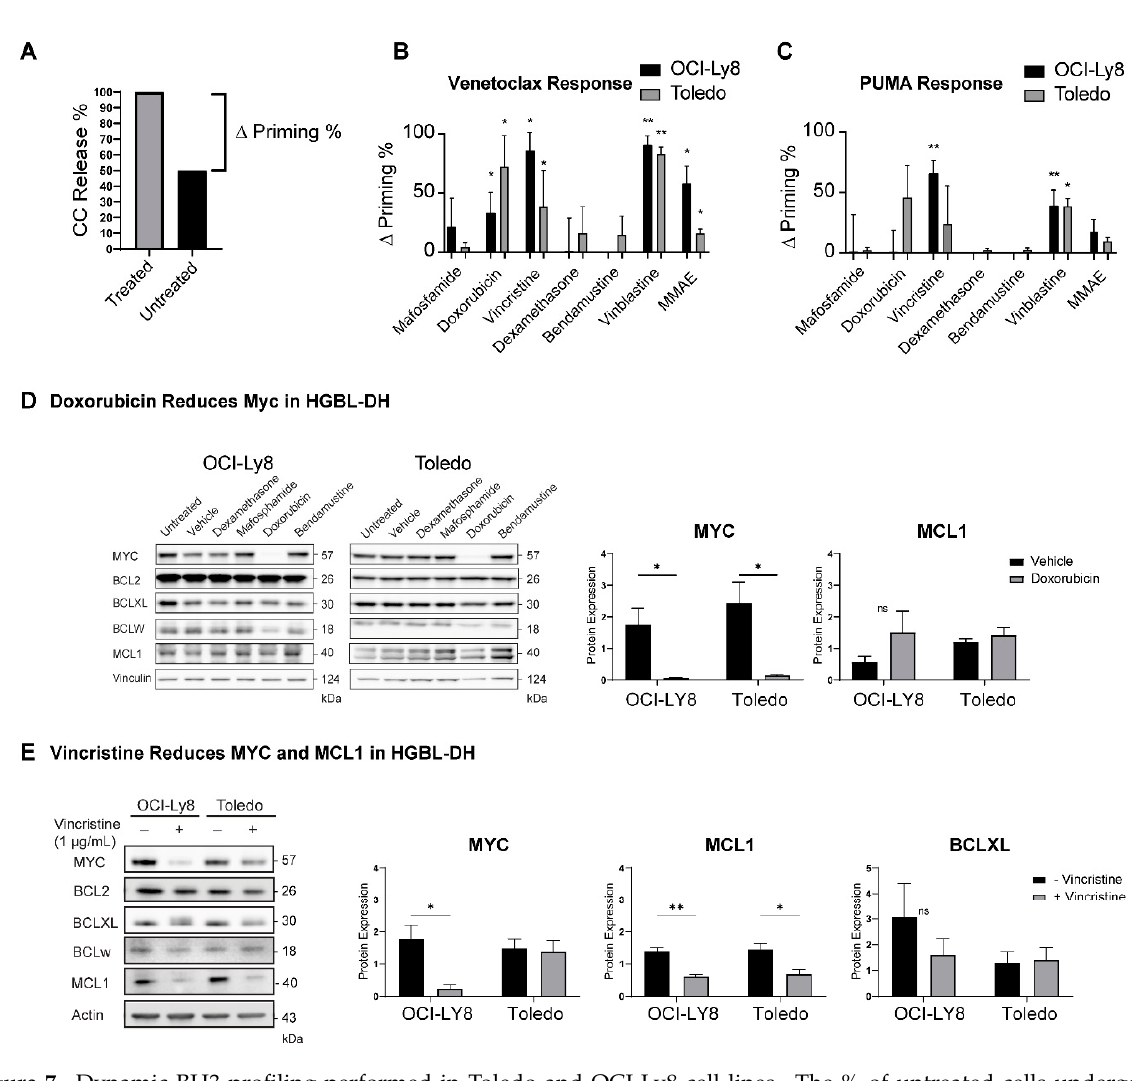
Figure 7. Dynamic BH3 profiling performed in Toledo and OCI-Ly8 cell lines. The % of untreated cells undergoing cytochrome c release was subtracted from the % of cells undergoing cytochrome c release in treated samples to determine an increase in release named “ ∆ Priming” (example shown in panel ( A )). Cytochrome c release was measured in cells upon exposure to 1 µ M of venetoclax ( B ) and 1 µ M PUMA ( C ) after a 17 h incubation with dimethyl sulfoxide (control) and different drugs. Welch’s t tests were used to compare individual treatments to the individual control groups. Microtubule targeting components of RCHOP such as doxorubicin and vincristine increased cells priming and sensitivity to venetoclax. * p < 0.05, ** p < 0.01. ( D ) Western blot measuring anti-apoptotic protein and MYC levels in OCI-Ly8 and Toledo cell lines after 17 h treatment with dexamethasone, mafosphamide, doxorubicin, and bendamustine. Doxorubicin significantly decreases the expression of MYC in both cell lines after treatment. ( E ) Western blot measuring anti-apoptotic protein and MYC levels in OCI-Ly8 and Toledo cell lines after 17 h treatment with vincristine. Bars measure the mean of all samples, error bars indicate SEM. Vincristine significantly reduces MCL1 expression in both cell lines while also reducing MYC expression in OCI-LY8. BCLXL was not significantly reduced after treatment with vincristine. * p < 0.05, ** p < 0.01. ns, non-significant.